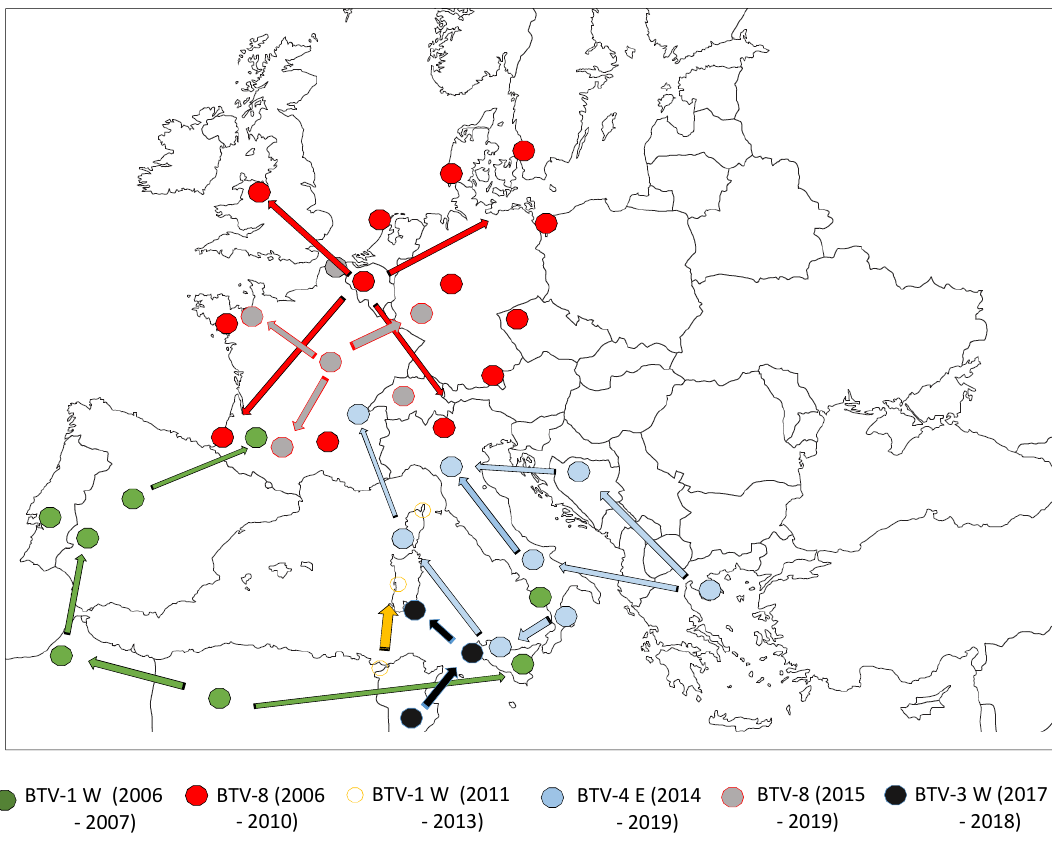
Figure 2. BTV spread from 2006 to 2019. Spread of BTV serotypes and strains (BTV-x) during the period indicated in brackets. E: Eastern strain; W: Western